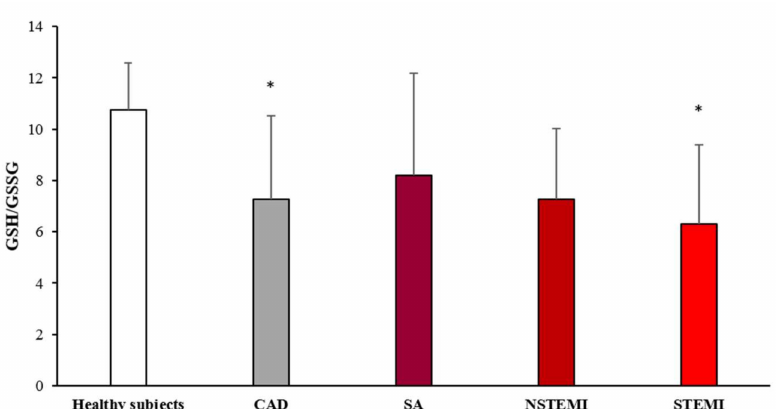
Figure 1. GSH / GSSG evaluation in monocyte-derived macrophages (MDMs). MDMs were obtained from CAD patients and healthy subjects. Data are expressed as mean ± SD and derive from independent cultures obtained from 10 healthy subjects and 30 CAD patients (SA n = 10; NSTEMI n = 10; STEMI n = 10. * p < 0.05 vs. healthy subjects.